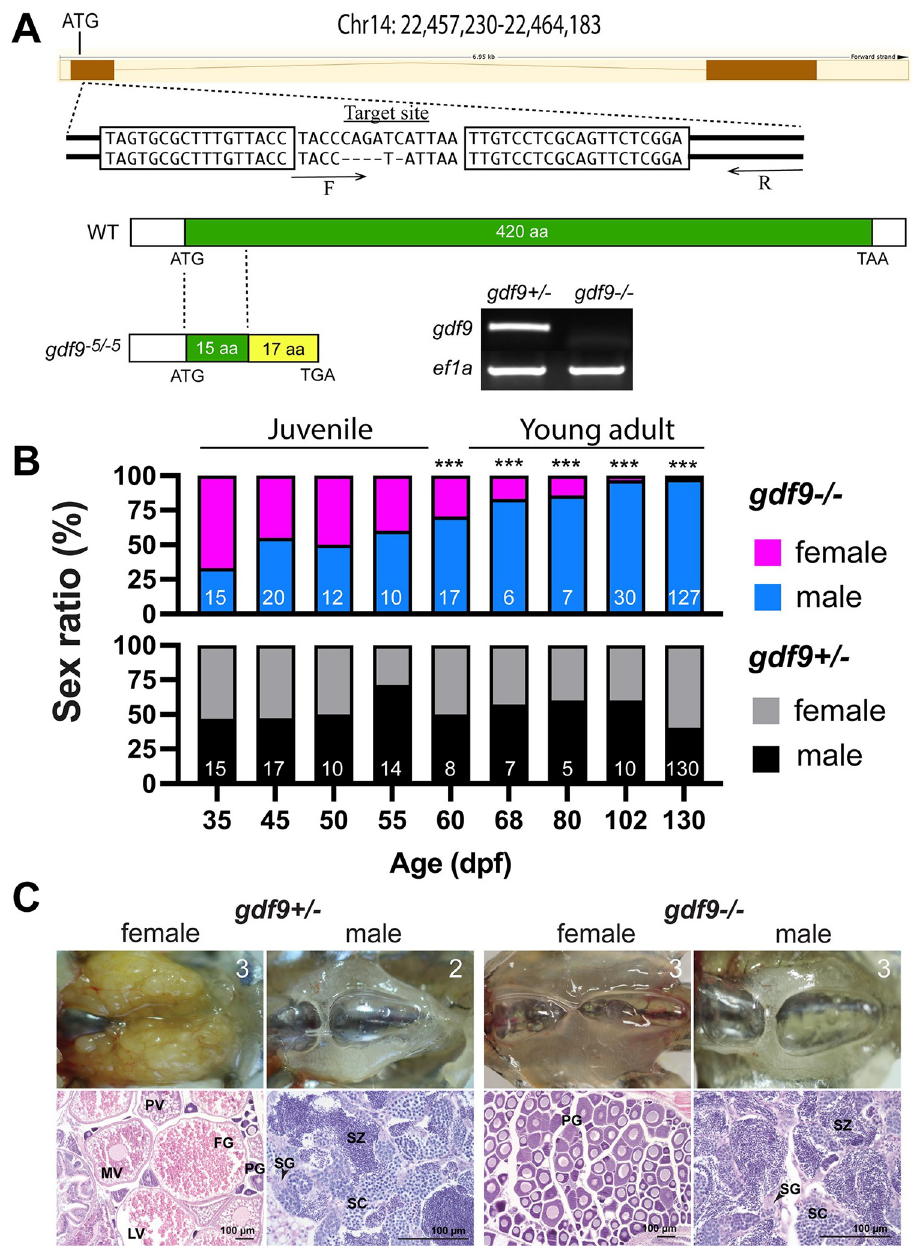
Fig 1. Disruption of gdf9 gene in zebrafish and evidence for its roles in gonadal differentiation and gonadal development. (A) Generation of gdf9 mutant by TALEN. The target site on chromosome 14 for left and right TALE proteins are boxed. A mutant with 5-bp deletion was obtained with a premature stop codon (TGA), which generated a truncated protein with 32 amino acids (15 from the Gdf9 precursor). RT-PCR analysis on mRNA from the ovary using a WT-specific primer (F) showed a positive signal in the control ovary ( gdf9 +/-), but not in the mutant ( gdf9 -/-). (B) Sex ratios during and after gonadal differentiation in gdf9 mutant fish. The offspring from one crossing ( gdf9 +/- female X gdf9 -/- male) were sampled at different times from 35 to 130 dpf for genotyping and sex identification by histology. The sex ratios in the post-differentiation period from 35 to 55 dpf remained relatively constant and comparable to those in the control fish. However, the ratio changed gradually but significantly afterwards towards all males. The number of fish examined is shown at the bottom of each column. ��� P < 0.001 (X 2 test). (C) The ovary and testis in the control ( gdf9+/- ) and mutant ( gdf9-/- ) at 90 dpf. The control females had reached sexual maturity with all stages of follicles present in the ovary (PG, primary growth; PV, pre-vitellogenic; MV, mid-vitellogenic; LV, late vitellogenic; and FG, full-grown) while the mutant ovary contained PG follicles only. The testis development and spermatogenesis showed no difference between mutant and control males. SG, spermatogonia; SC, spermatocytes; SZ, spermatozoa. The number in each photo indicates the number of fish examined with the same